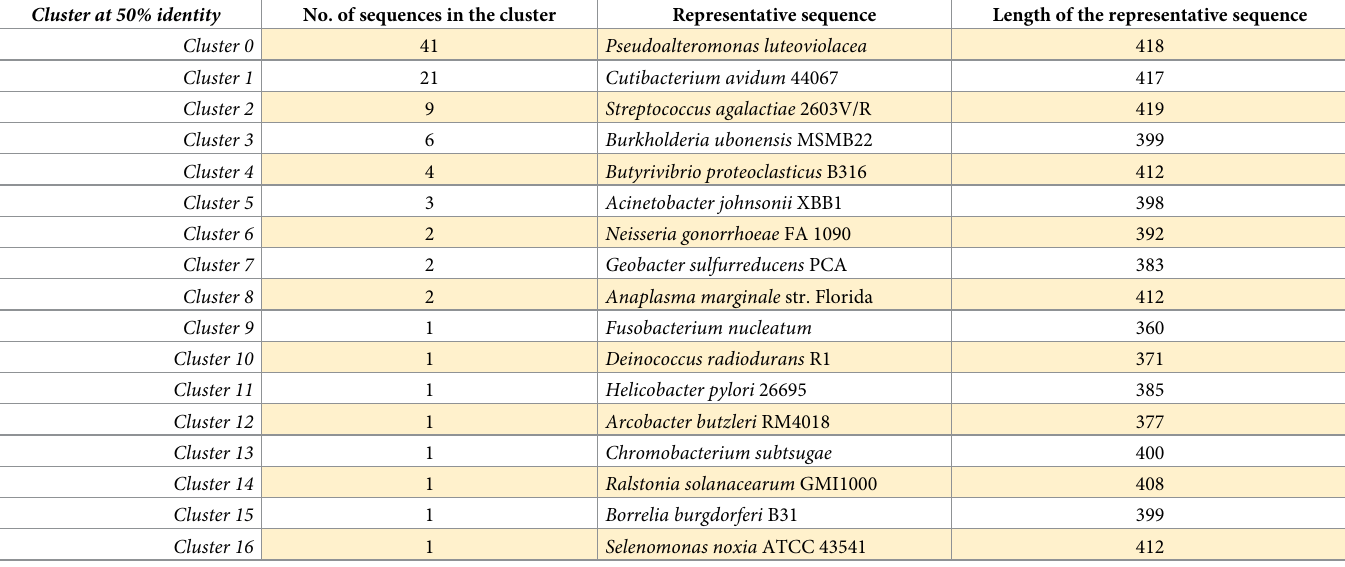
Table 2. Clusters of ftsZ gene sequences generated using CD-HIT with a similarity threshold of 50 percent. Cluster at 50% identity No. of sequences in the cluster Representative sequence Length of the representative